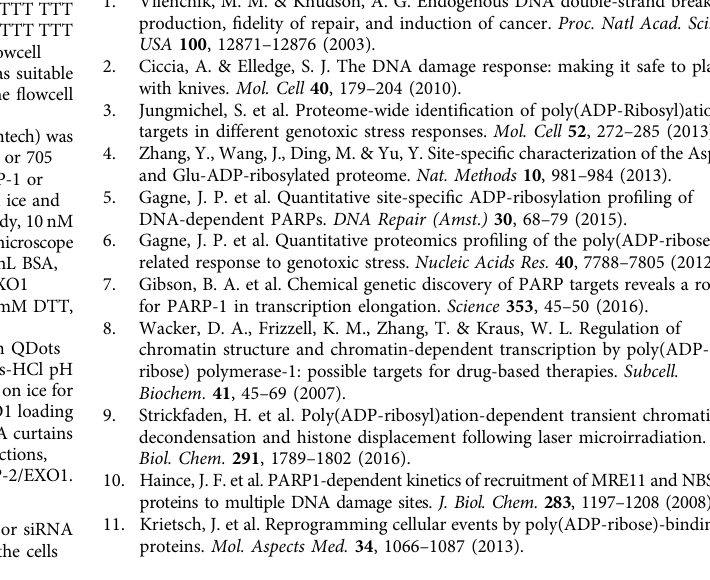
Single-molecule analysis of resection tracks . The indicated cell lines or siRNA transfected cells were incubated with 10 µM BrdU for 48 h. After 48h, the